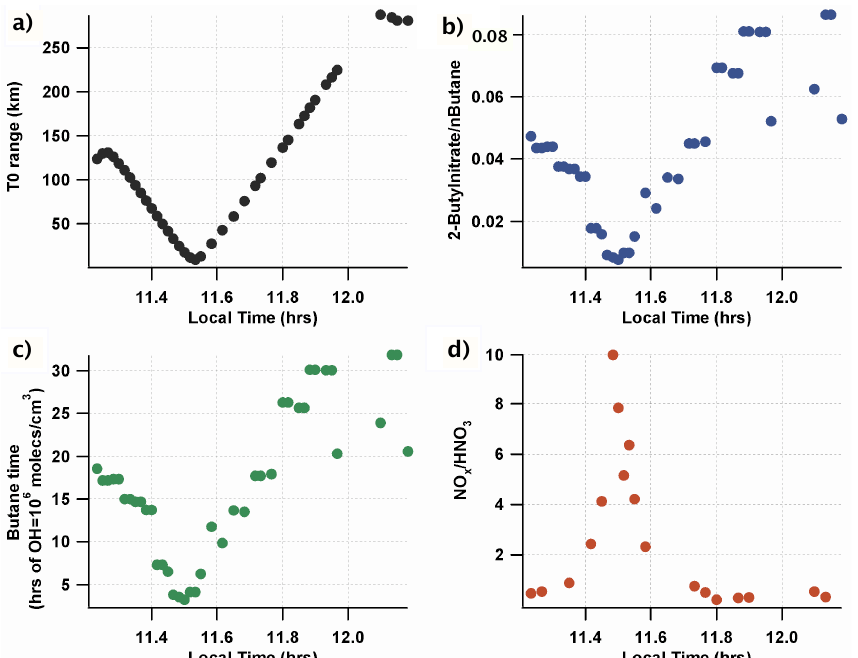
Fig. 1. An example from the DC8 Flight #7 of 16 March 2006 of the variation of several indicators of chemical age with distance from the center of Mexico City. Panel (a) shows the distance to Mexico City, panel (b) shows the ratio of 2-butyl nitrate to butane, panel (c) shows the photochemical age inferred from the 2-butylnitrate/butane ratio and panel (d) shows the ratio of NO x to HNO 3